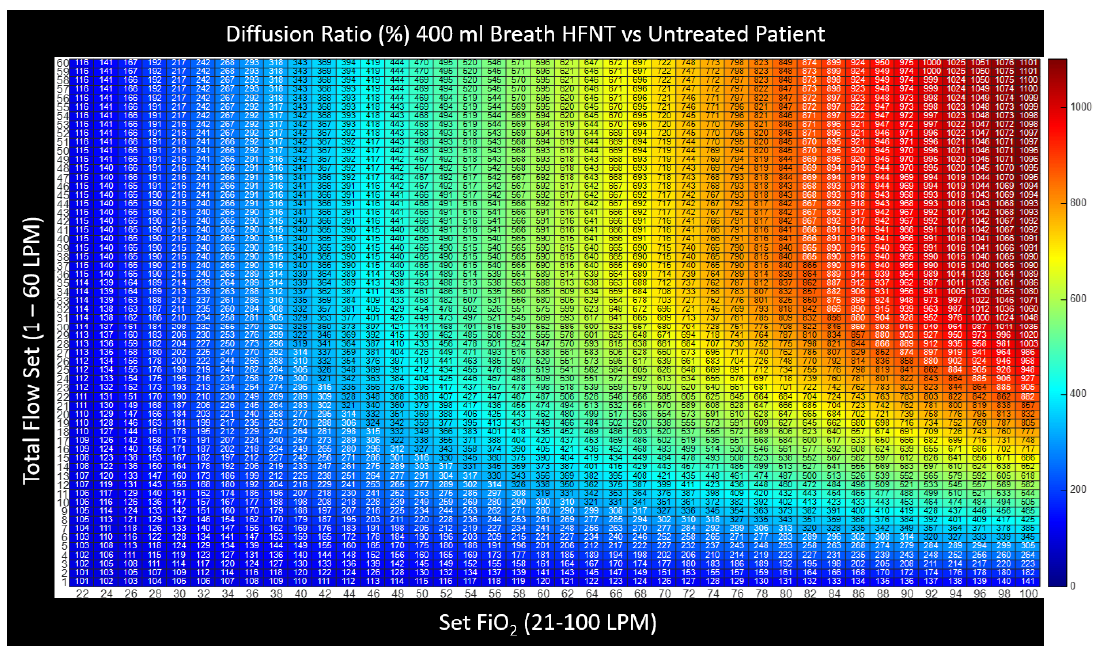
Figure 7. A chart representing the effectiveness of HFNT versus no treatment. The percentage (%) indicates the maximum diffusion rate induced to hypoxemic blood with HFNT treatment at a particular setting as a ratio to the maximum diffusion rate from breathing room air without intervention. This figure’s overall characteristic correlates to the heatmaps for tracheal F i O 2 in Figure 6, indicating an ANOVA of treatment efficacy is primarily associated with F i O 2